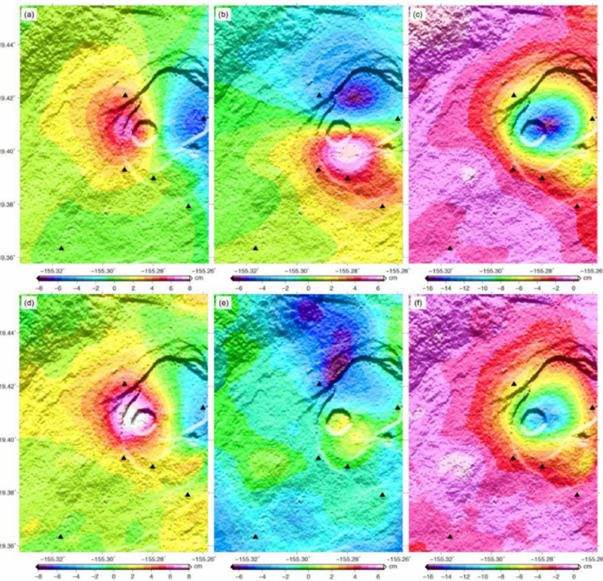
Figure 10. ( a – c ) East, north, and up displacement components of Kilauea volcano from ascending PALSAR images acquired on 5 May and 20 June 2007 and a surface displacement model. ( d – f ) The same displacement components estimated from weighted-least-squares adjustment of InSAR and MAI results from both the ascending PALSAR data and descending PALSAR data of 28 February and 16 July 2007